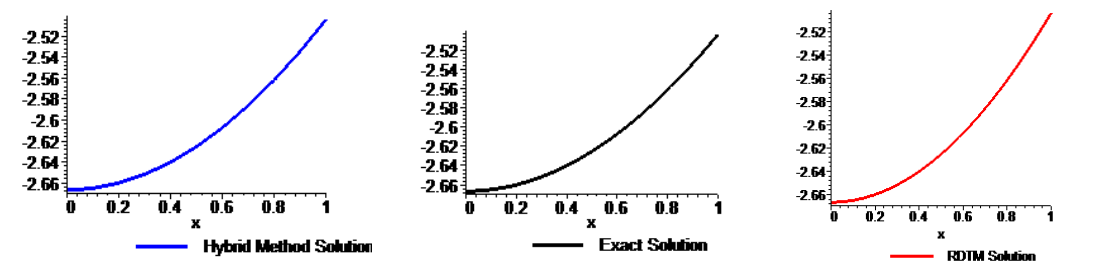
Fig. 1 2D curves of Hybrid method, Exact and RDTM solutions for t = 0 , 0001.